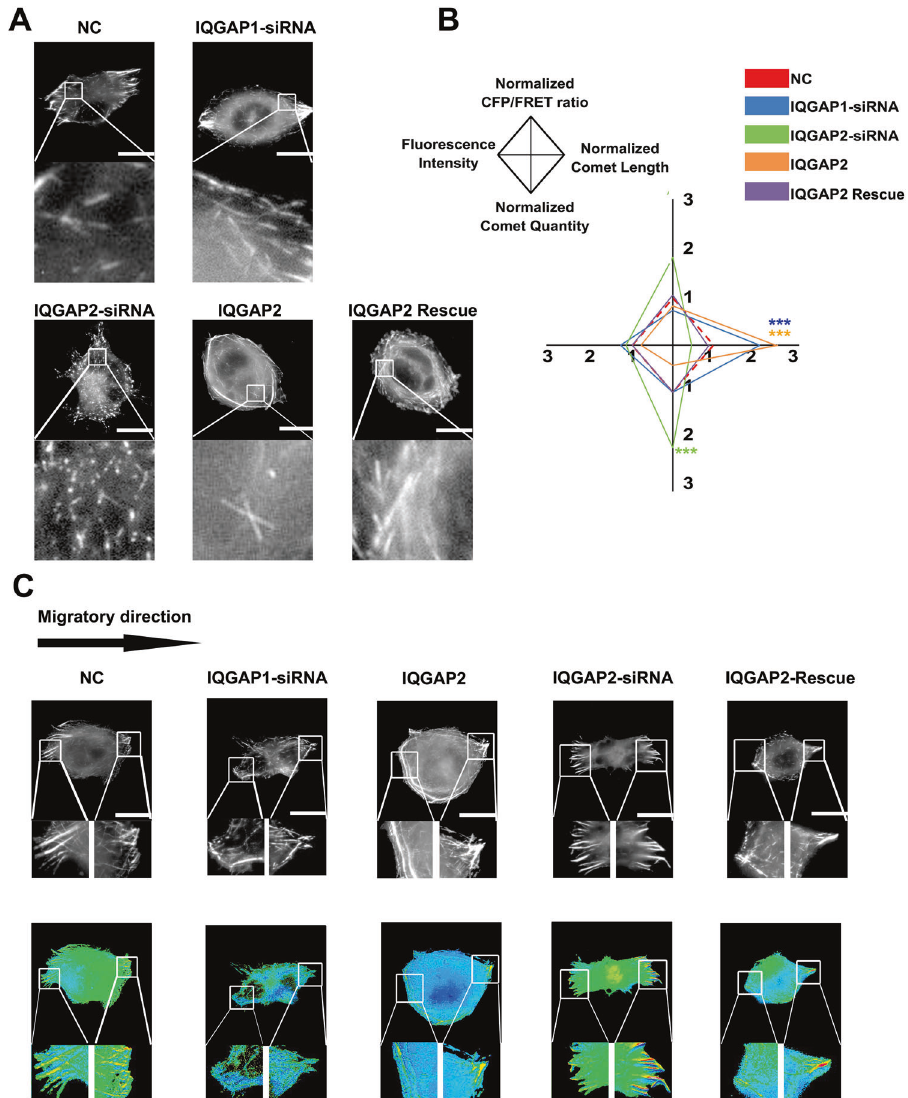
Fig. 8 IQGAP1 and 2 are correlated in Clip170 tension magnitude and distribution. A Representative images of MDA-MB-468 expressing the Clip170-cpstFRET probe in the IQGAP1 -siRNA, IQGAP2 -siRNA, IQGAP2 overexpression, and IQGAP2 rescue groups. B Normalized CFP/FRET signals, comet lengths, comet quantities, and fl uorescence intensities for the whole cell in the different groups (scale bar, 10 μ m, n ≥ 6 cells in each group, *** P < 0.001 compared with NC group). C Representative images of MDA-MB-468 cells expressing the Clip170-cpstFRET probe in the IQGAP1 -siRNA, IQGAP2 -siRNA, IQGAP2 overexpression, and IQGAP2 rescue groups in the directional migration model, scale bar, 10 μ